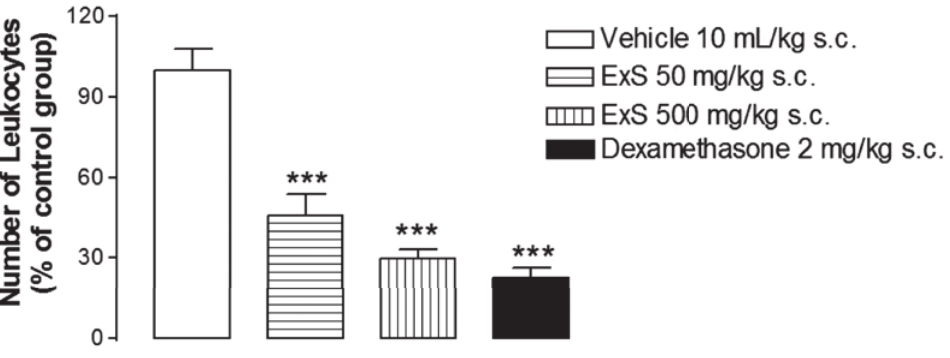
Figure 4 - Effect of Streptoverticillium sp. extracts, ExS 200 and 500 mg/kg, s.c., on carrageenan- induced peritonitis in mice. The vertical bars indicate the mean ± SEM of total number of leukocytes migrated to peritoneum. Dexamethasone (2 mg/kg, s.c.) was used as a positive control. *** p < 0.001, vs control group (vehicle).